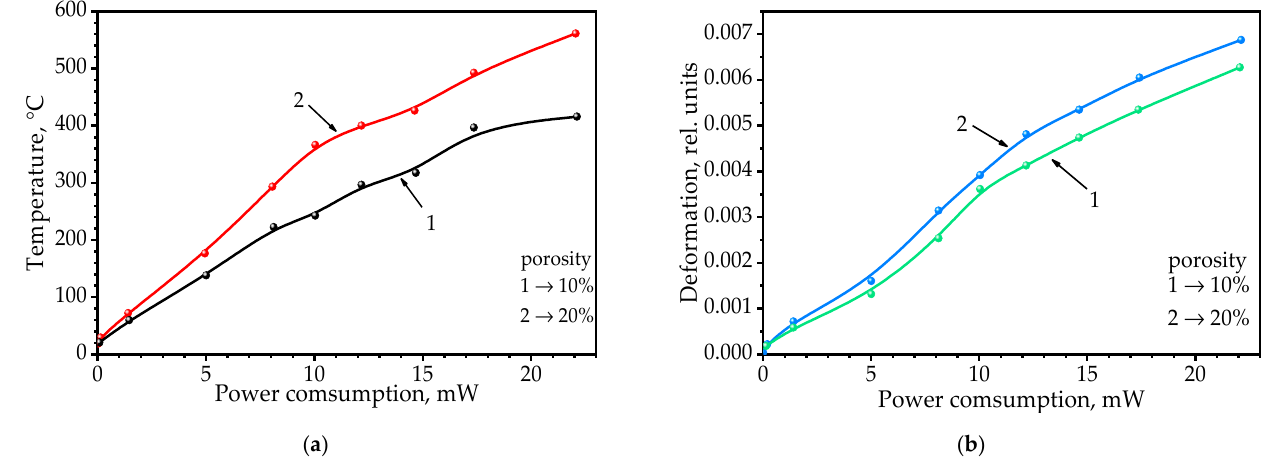
Figure 8. ( a ) Dependence of the heating of the gas-sensitive layer on the power dissipated by the heating element for a membrane porosity of 10% (curve 1) and 20% (curve 2). ( b ) Dependence of the membrane deformation on the power dissipated by the heating element for a membrane porosity of 10% (curve 1) and 20% (curve 2).